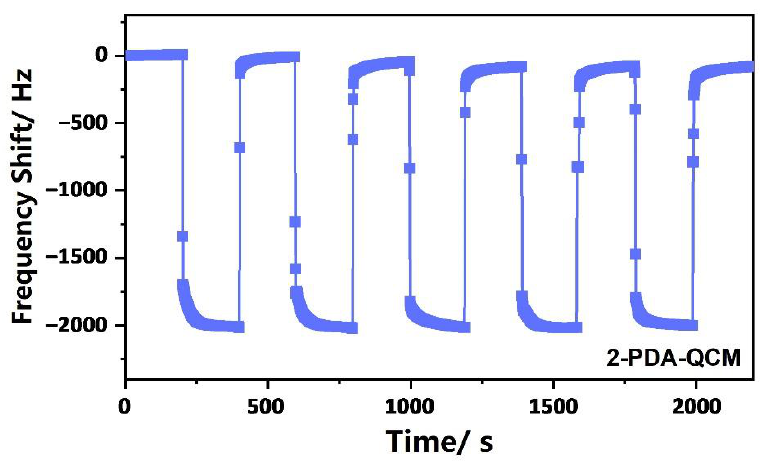
Figure 9. The repeatability of 2-PDA-QCM at the relative humidity between 11% and 95% for five cycles.